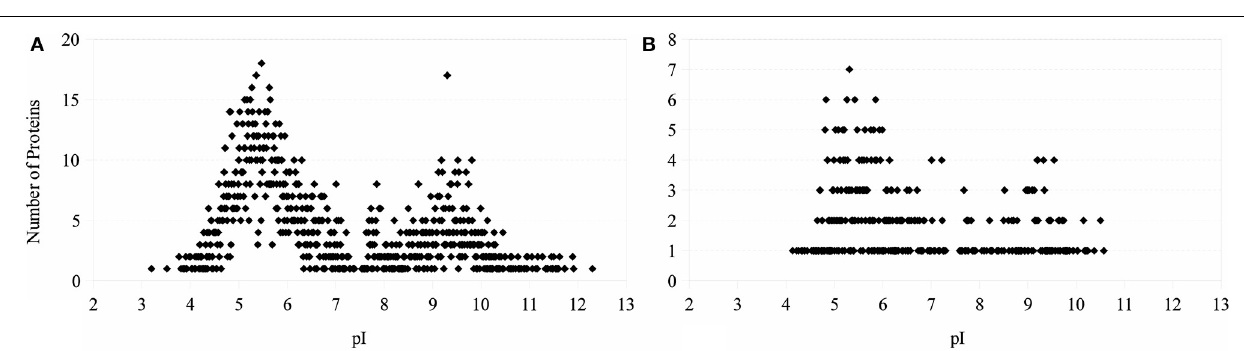
FIGURE 7 | Number of proteins as a function of isoelectric point. (A) Theoretical distribution based on the proteome of PV-1. (B) Theoretical distribution based on proteins with molecular weights between 33.6 and 51.1kDa (common range of MW of the proteins identified between osmotic-shock and crude